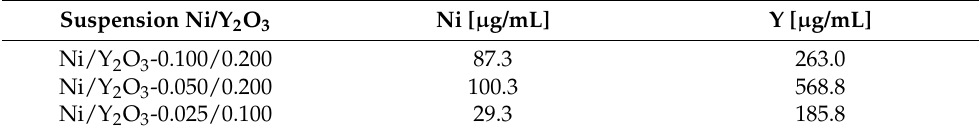
Table 2. The concentration of nickel and yttrium in the USP synthesised suspensions. Suspension Ni/Y 2 O